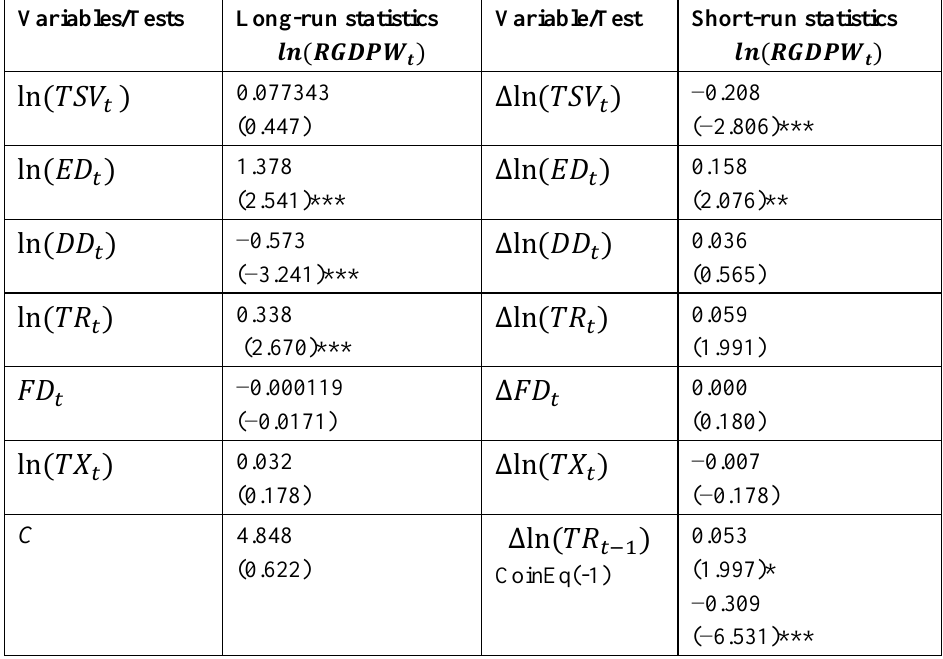
Table 6. Long-run and short-run relationship coefficient